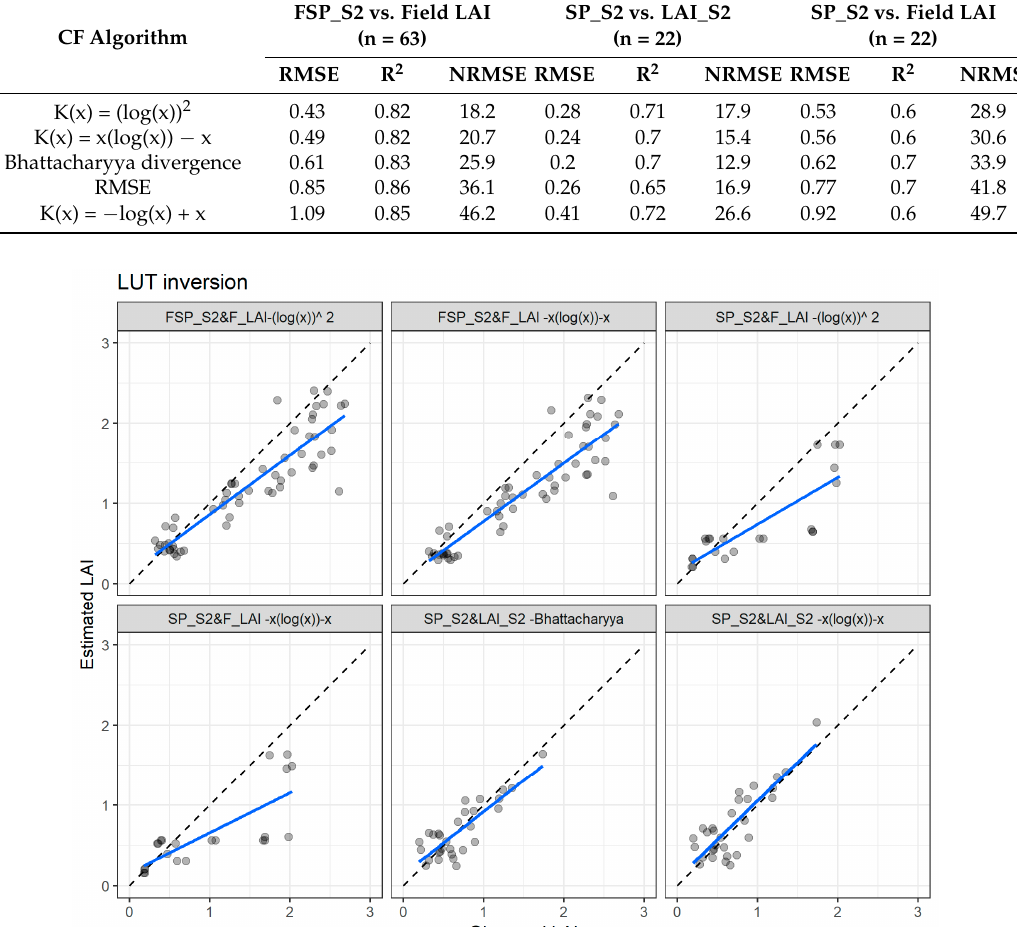
Figure 12. Comparisons of the measured and estimated LAI of the best LUT inversion cost functions using the field spectral data resampled to Sentinel-2 bands with the field leaf area index (FSP_S2 vs. F_LAI—first two plots), Sentinel-2 spectral data with field leaf area index data (SP_S2 vs. F_LAI—third and fourth plots), and Sentinel-2 spectral data with Sentinel-2 leaf area index product data (SP_S2 vs. LAI_S2—last two plots). The full line depicts the linear regression and the dashed line the linear regression through